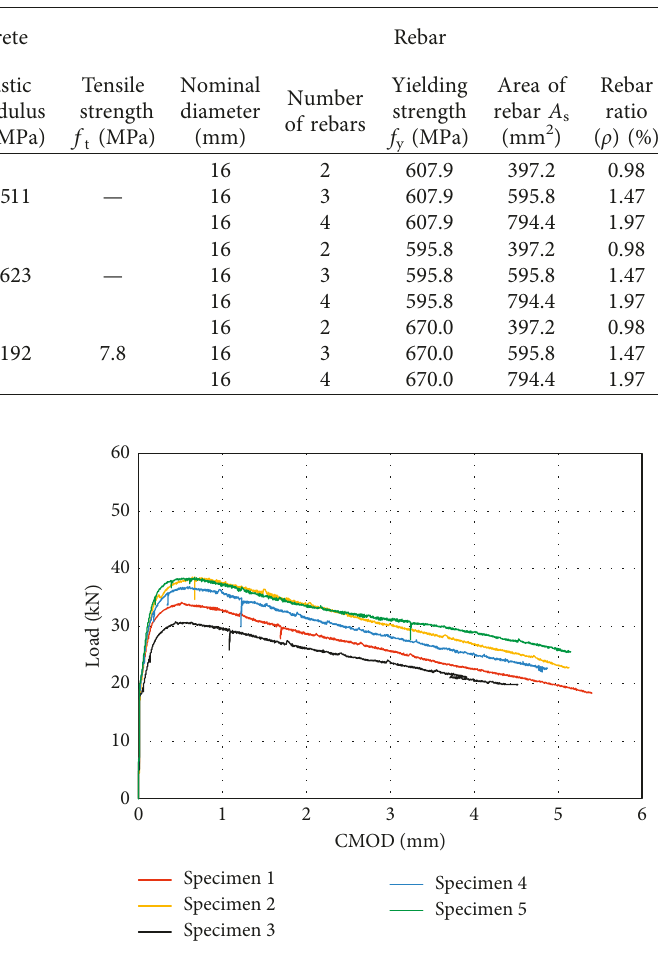
Table 2: Details of the beam specimens.